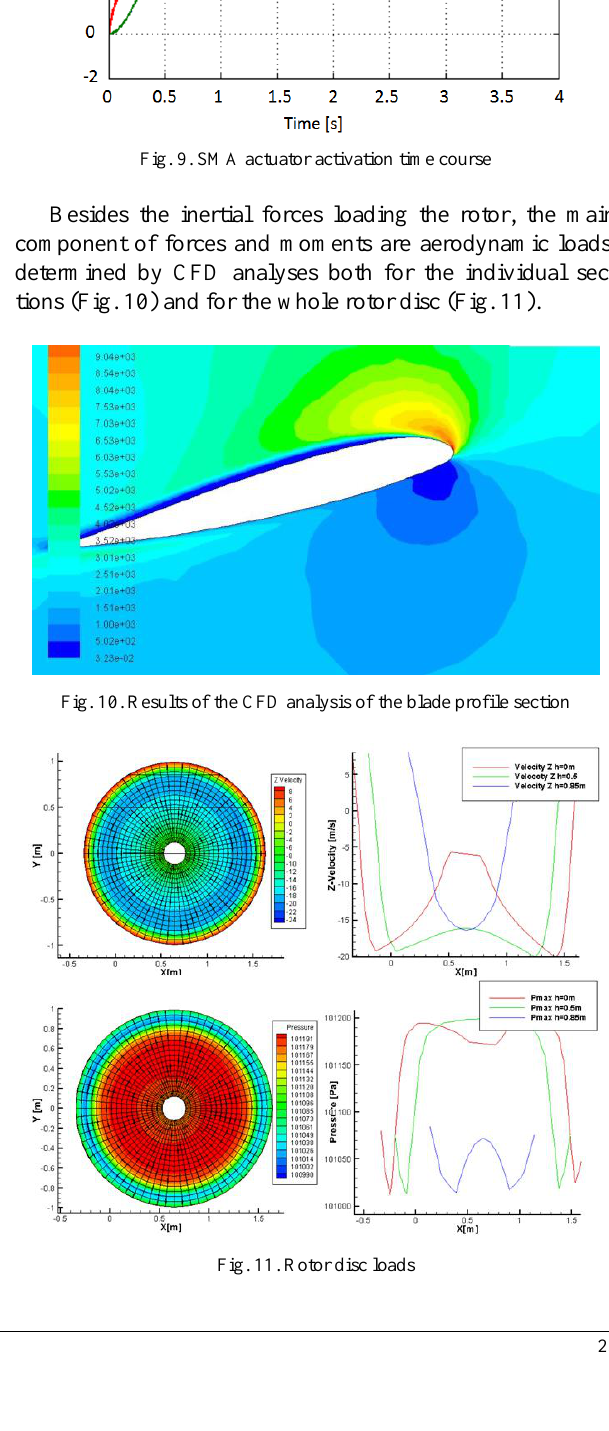
Fig. 5. Rotor thrust